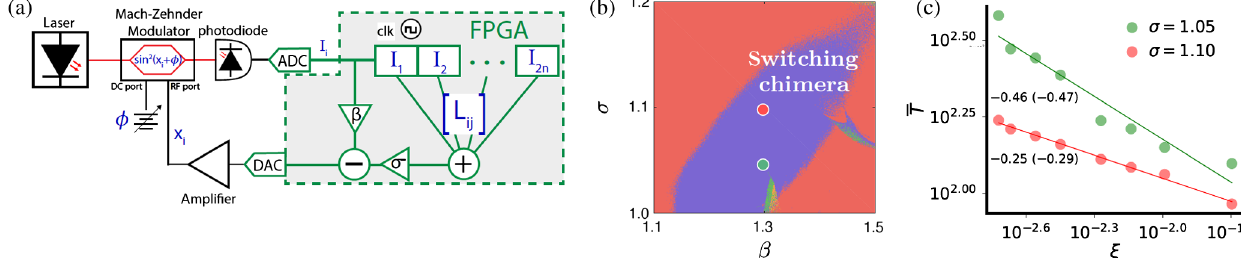
8. Experimental realization of globally attractive switching chimeras. (a) Schematic diagram of the optoelectronic system, where the dashed box depicts our implementation of the coupling scheme. (b) Parameter space color coded according to direct simulations of Eq. (9). The regions shown include switching chimeras (purple), nonswitching chimeras (green), chimera death [18] (yellow), and ¯ T incoherence (red). (c) Experimentally measured average switching period as a function of the noise intensity ξ for β ¼ 1 . 3 and two values of σ [dots in (b)]. The scaling exponents annotated on the figure are obtained through linear least-square fitting applied to the ¯ T relationship between log ð Þ and log ð ξ Þ . The exponents obtained from experiments are in good agreement with those predicted from simulations (shown in